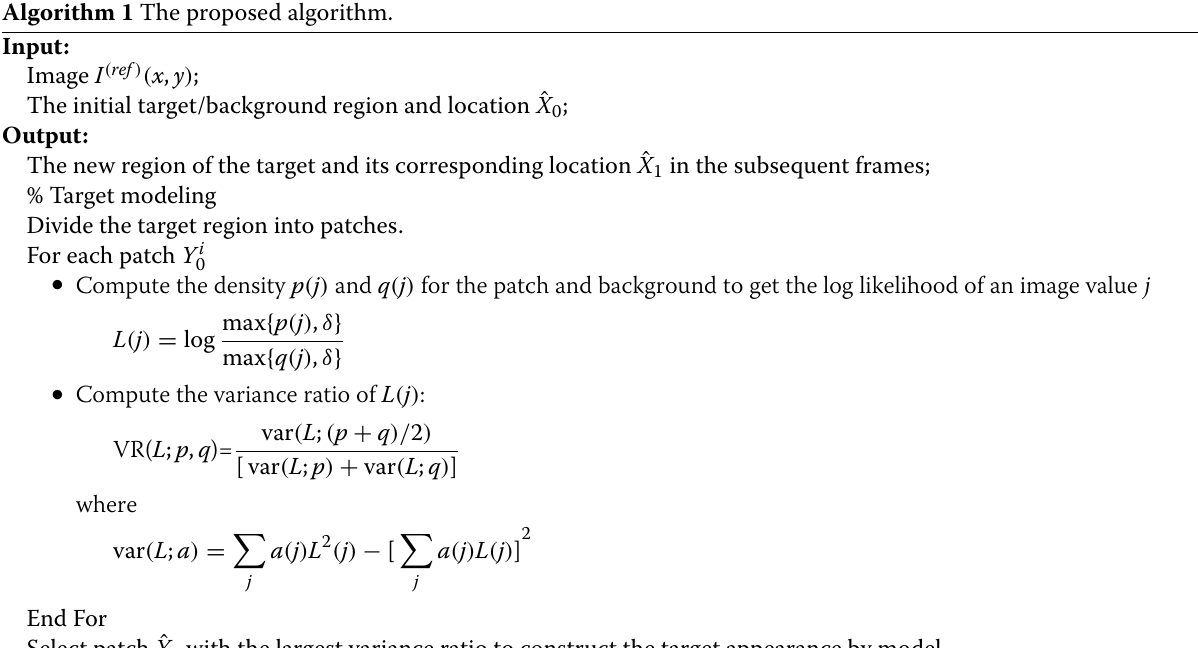
Algorithm 1 The proposed